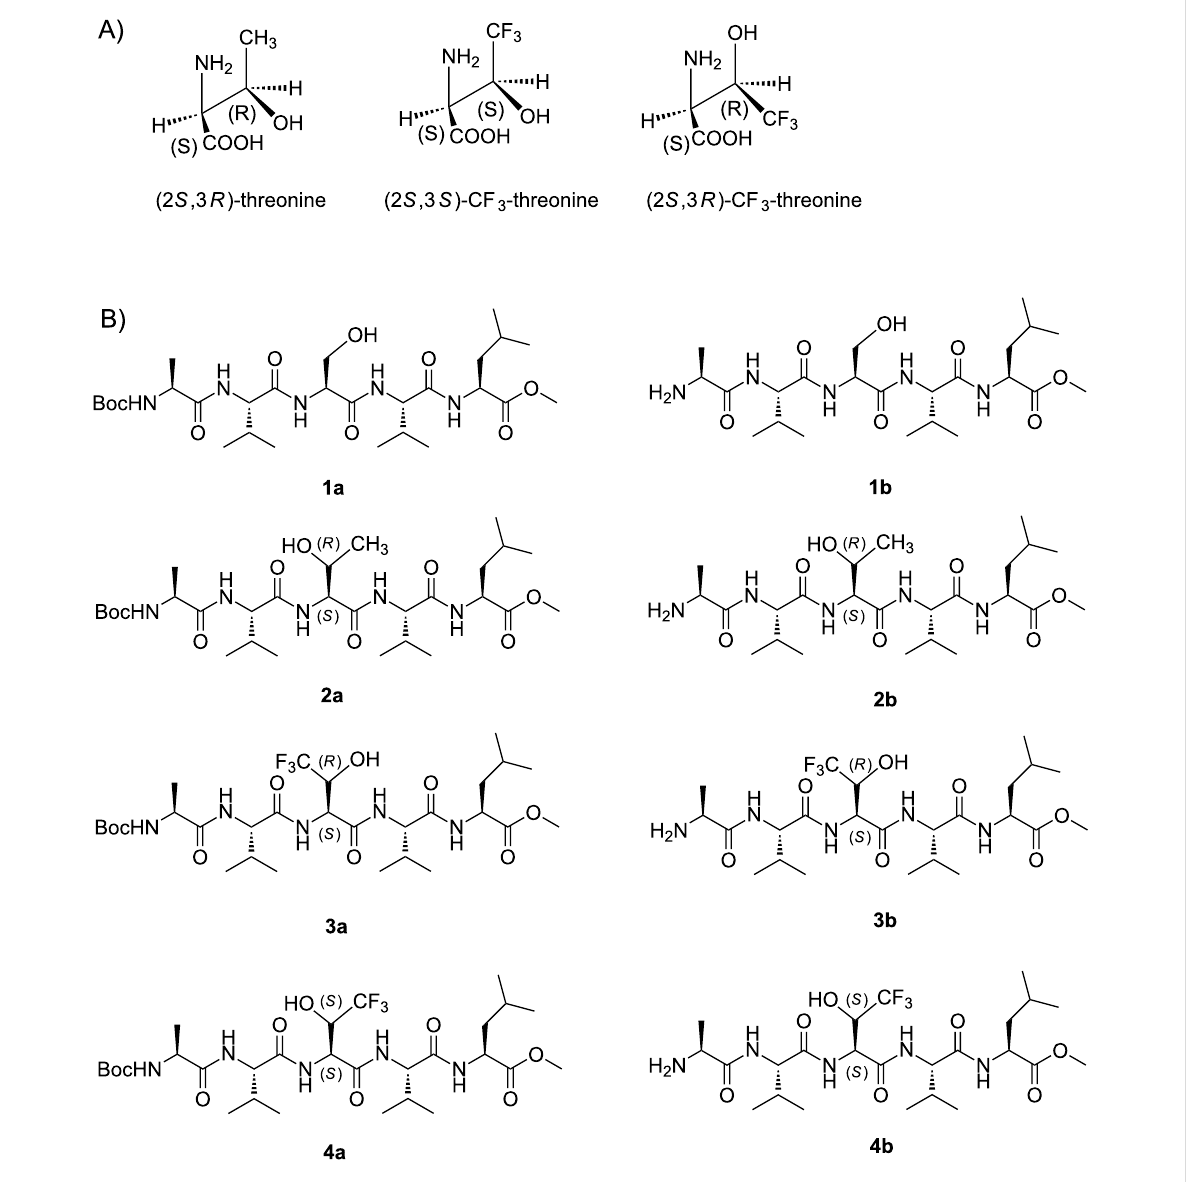
Figure 1: A) Natural threonine and its trifluoromethyl analogues sawhorse projections. B) Structure of Boc-protected pentapeptides 1a – 4a and free amine pentapeptides 1b – 4b